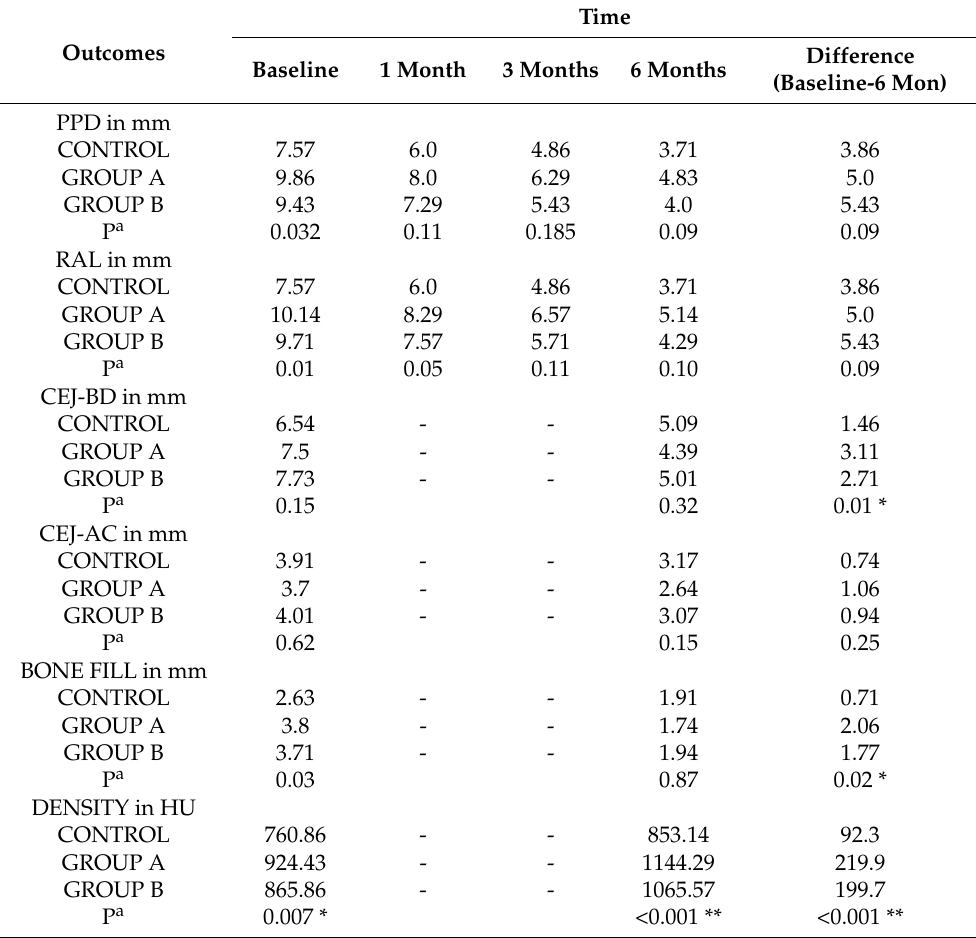
Table 2. Intergroup and intragroup comparison of Mean values of PPD, RAL, radiographic charac- teristics including Bone fill and Bone Density according to CBCT in Hounsfield unit (HU) between Control, Group A and Group B at Baseline 1, 3 and 6